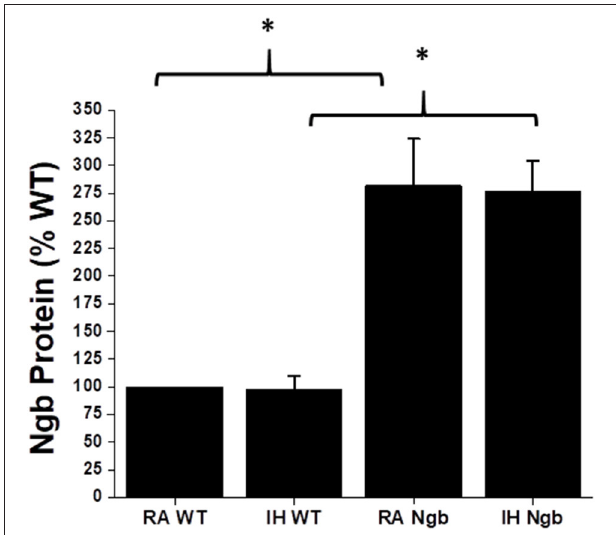
FIGURE 2 | Ngb protein expression in brain tissues in wild type (WT) and Ngb TG mice exposed to room air or IH. Although Ngb TG mice exhibit significantly increased expression of Ngb protein, IH did not induce significant changes in Ngb expression in either WT or Ngb TG mice. (* p -value < 0.01; n =